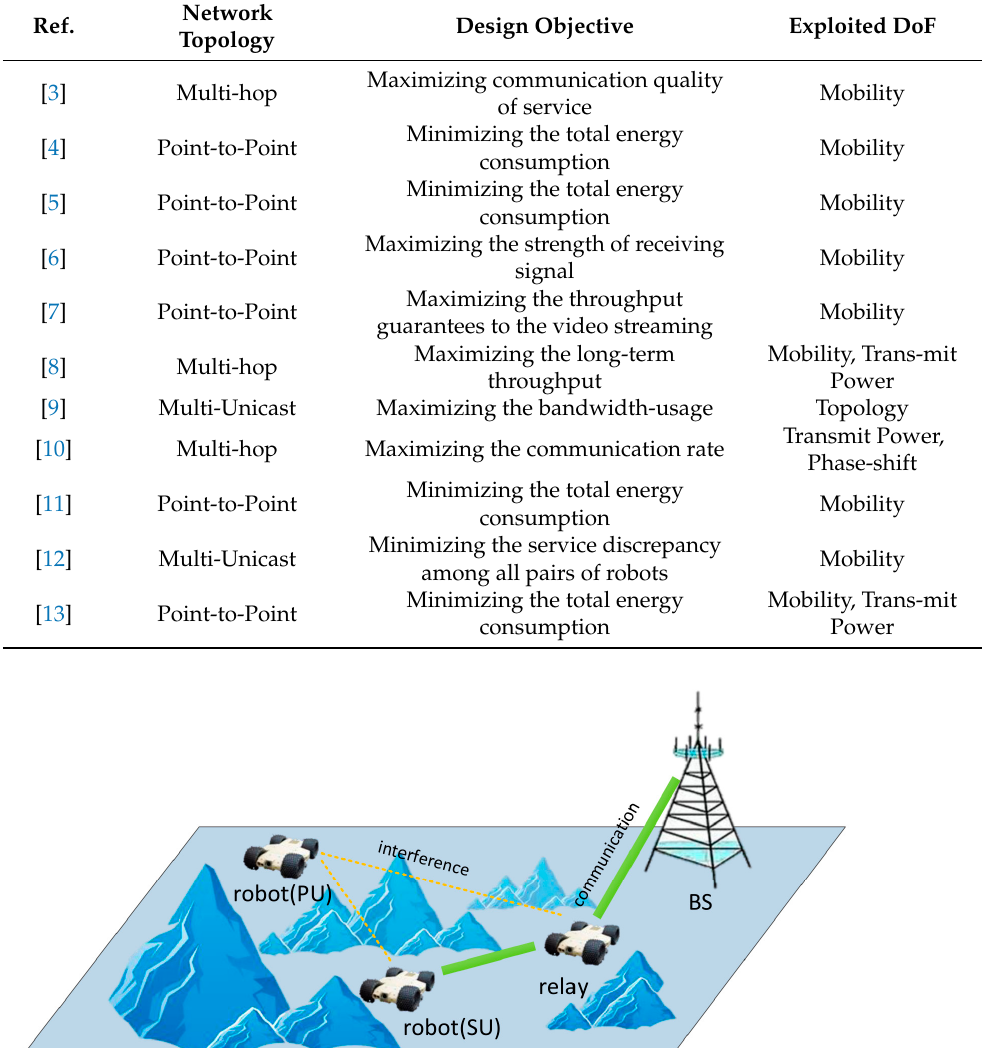
Table 1. Contributions on communication-aware motion planning (CAMP) in networked robotic system (NRS).